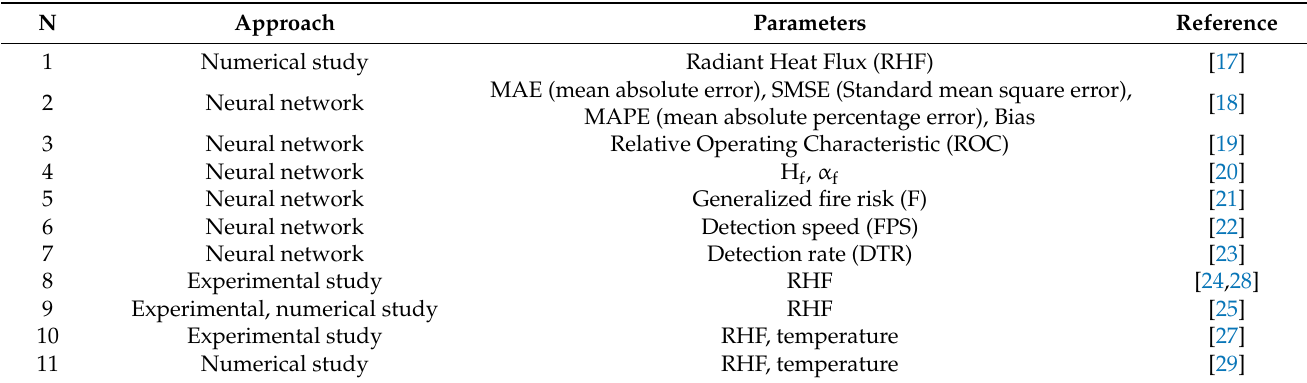
Table 1. Fire impact